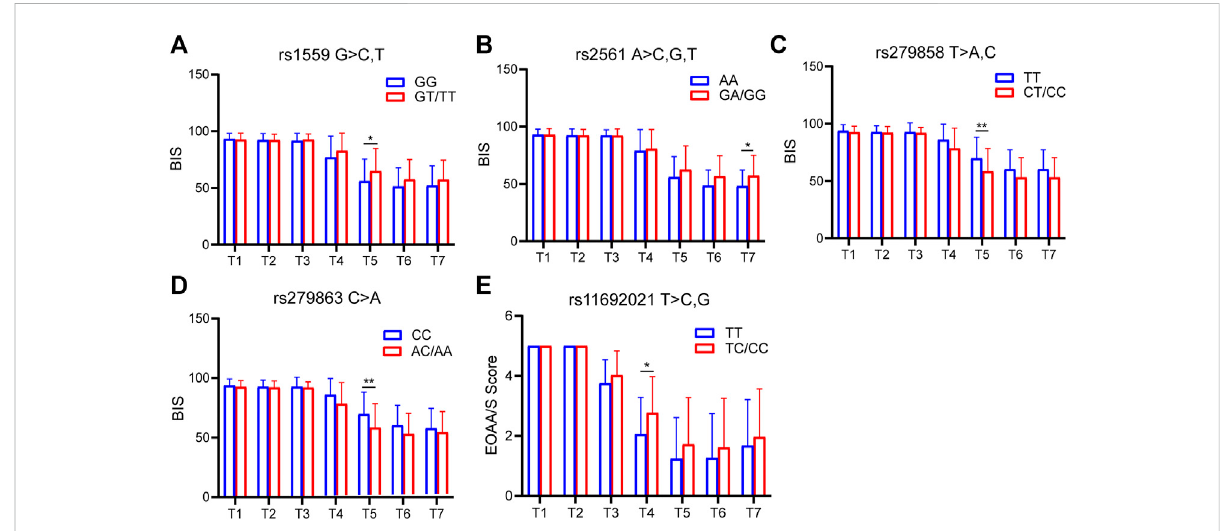
FIGURE 4 SNPsassociatedwithBISandEOAA/Sscores. (A) BISofCYP2C9rs1559 ateachtimepoint.Comparedwiththehomozygousforthemajorallele, theheterozygousforthemajoralleleandhomozygousfortheminorallelehadhigherBISat90 s.Thedifferencewasstatisticallysigni fi cant. (B) BISof GABRB2rs2561 ateachtimepoint. (C) BISofGABRB2rs279858 ateachtimepoint. (D) BISofGABRB2rs279863 ateachtimepoint. (E) EOAA/Sscore of UGT1A9 rs11692021 at each time point. T1, 5 min after the patients entered the room; T2, before the administration of etomidate; T3, 30 s; T4, 60 s; T5, 90 s; T6, 120 s; T7, 150 s after the etomidate. Two-way ANOVA was used as statistical analysis. * p < 0.05, ** p < 0.01.